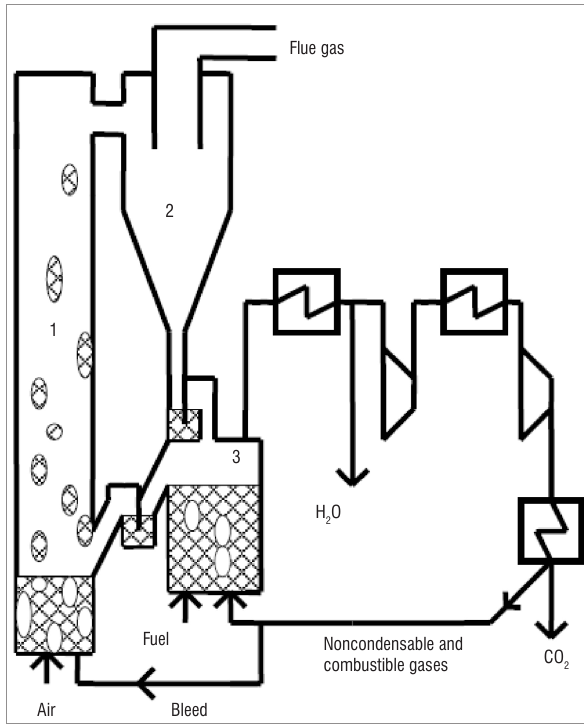
Figure 16: An illustration of chemical looping combustion. 49